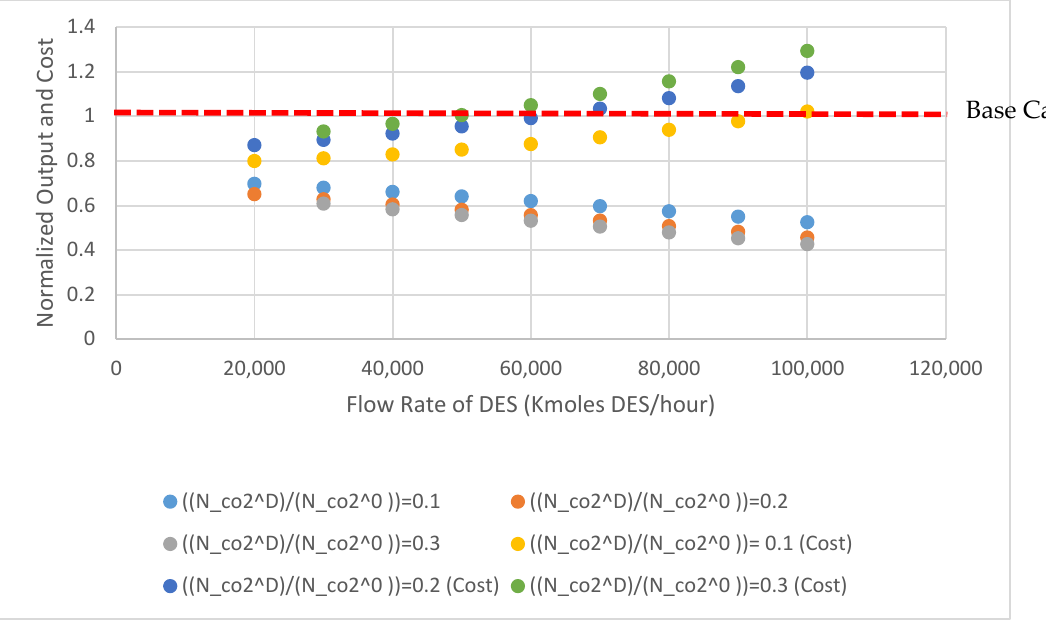
Figure 3. Normalized plant output and cost for METPB:EG SYSTEM, values for net plant power output and overall cost are normalized to NETL’s case B11B.